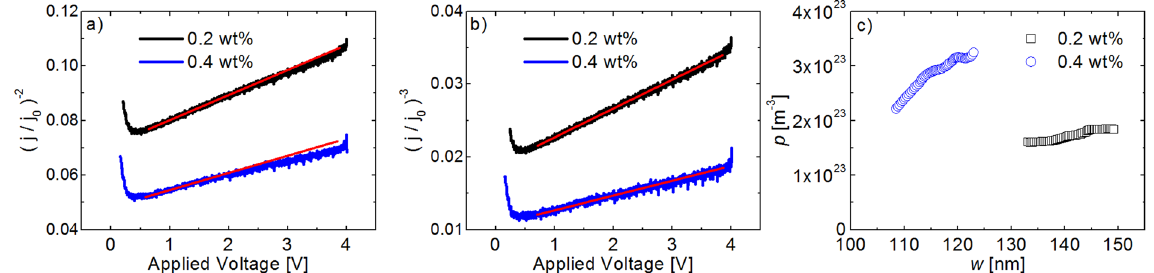
Figure 6. Capacitive extraction-current transients of P3HT devices is plotted as ( a ) ( j / j 0 ) − 2 and ( b ) ( j / j 0 ) − 3 vs applied voltage, for 0.2 wt % and 0.4 wt % dopants, where d = 300 nm. In this case the carrier profile is linearly increasing and a linear dependence can be seen in ( b ) in accordance with Eq. (12). The red lines in ( a and b ) are guides to the eye representing a straight line. In ( c ) the corresponding charge carrier profile is shown as a function of the depletion layer